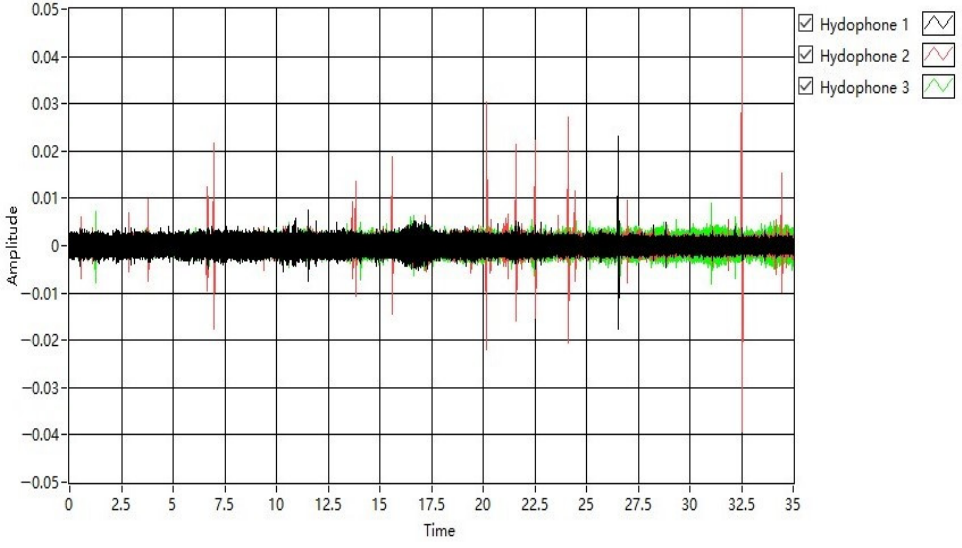
Figure 17. Substations time domain